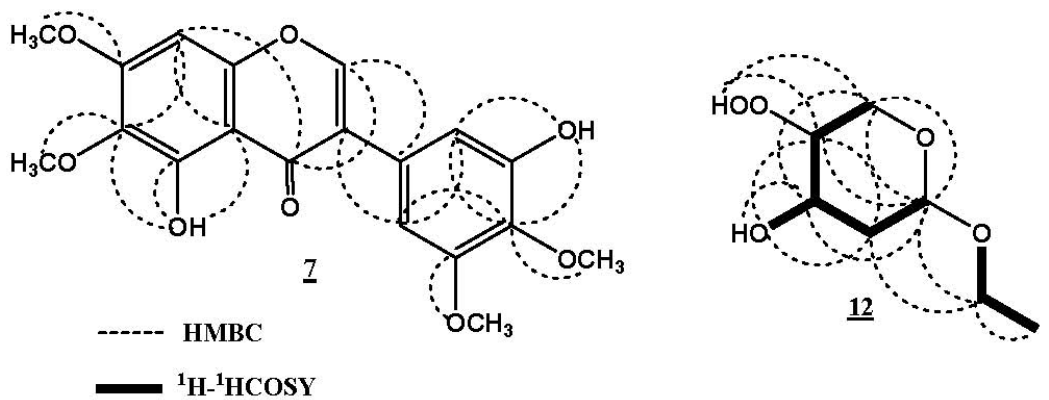
Figure 2. Important 1 H- 1 H COSY and HMBC correlations of 7 and